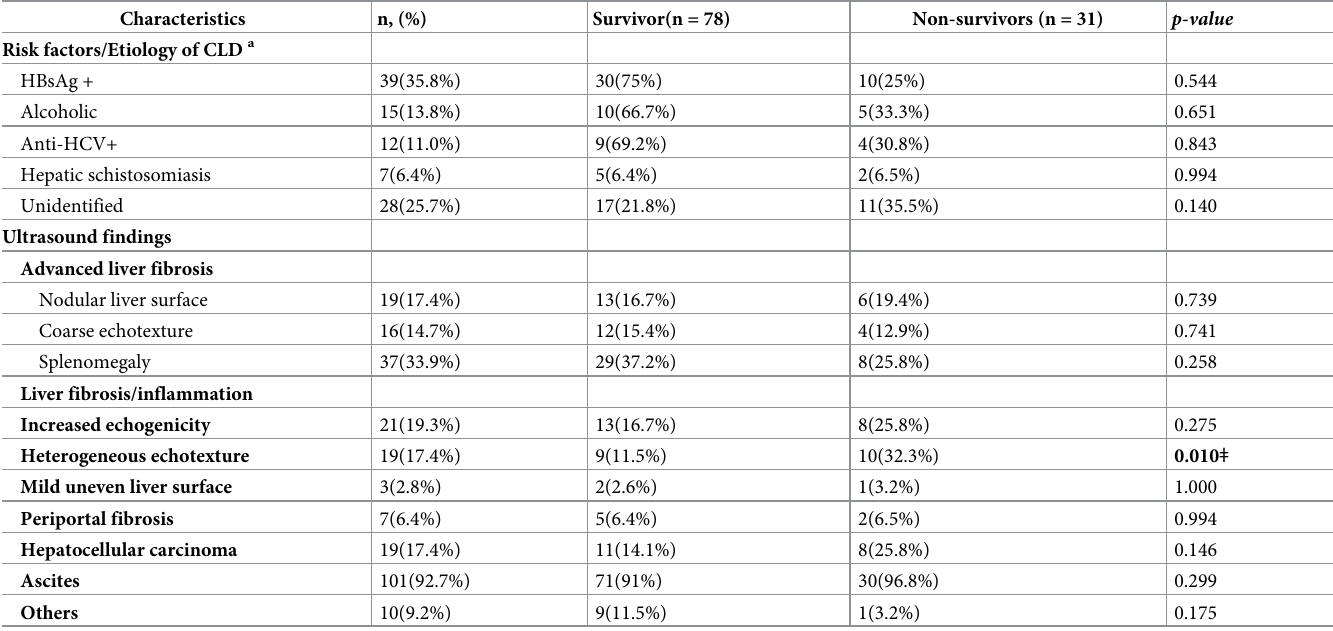
Table 2. Risk factors/etiologies of CLD, and ultrasound findings of the liver in relation to their association with hospital outcome.